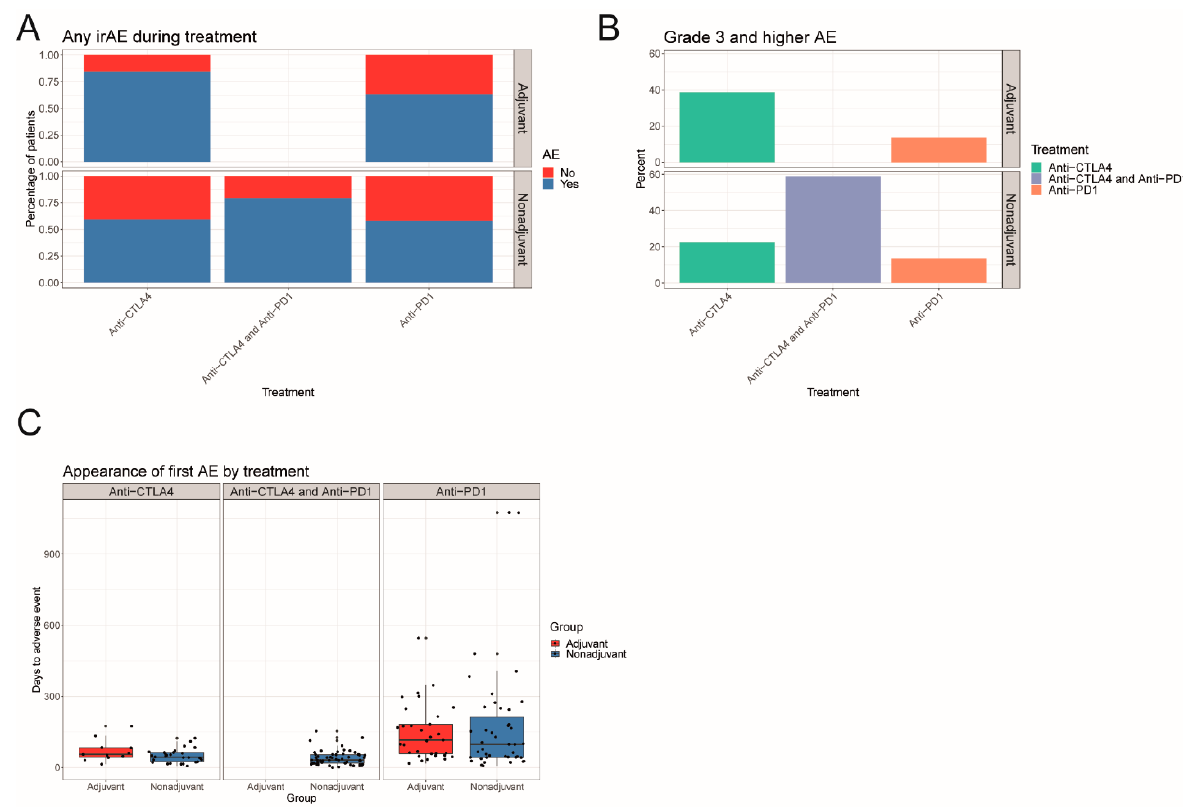
Figure 1. Frequency and time of appearance of irAEs in the adjuvant and non-adjuvant setting. ( A ) Barplot representing the frequencies of any irAE by treatment faceted by the adjuvant and non-adjuvant setting. ( B ) Barplot representing the frequencies of grade 3 and higher irAE by treatment faceted by the adjuvant and non-adjuvant setting. ( C ) Boxplots representing the appearance of the first irAE by treatment in the adjuvant and non-adjuvant setting.